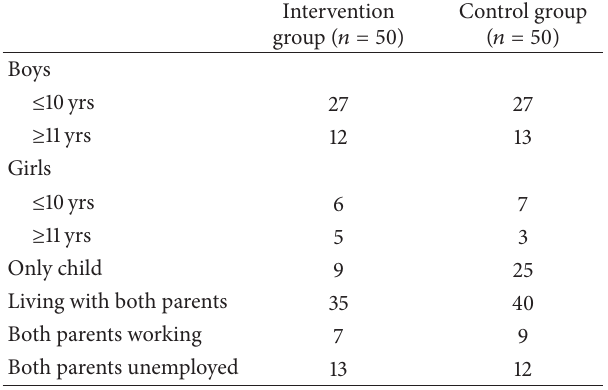
Table 2: The demographic information of the